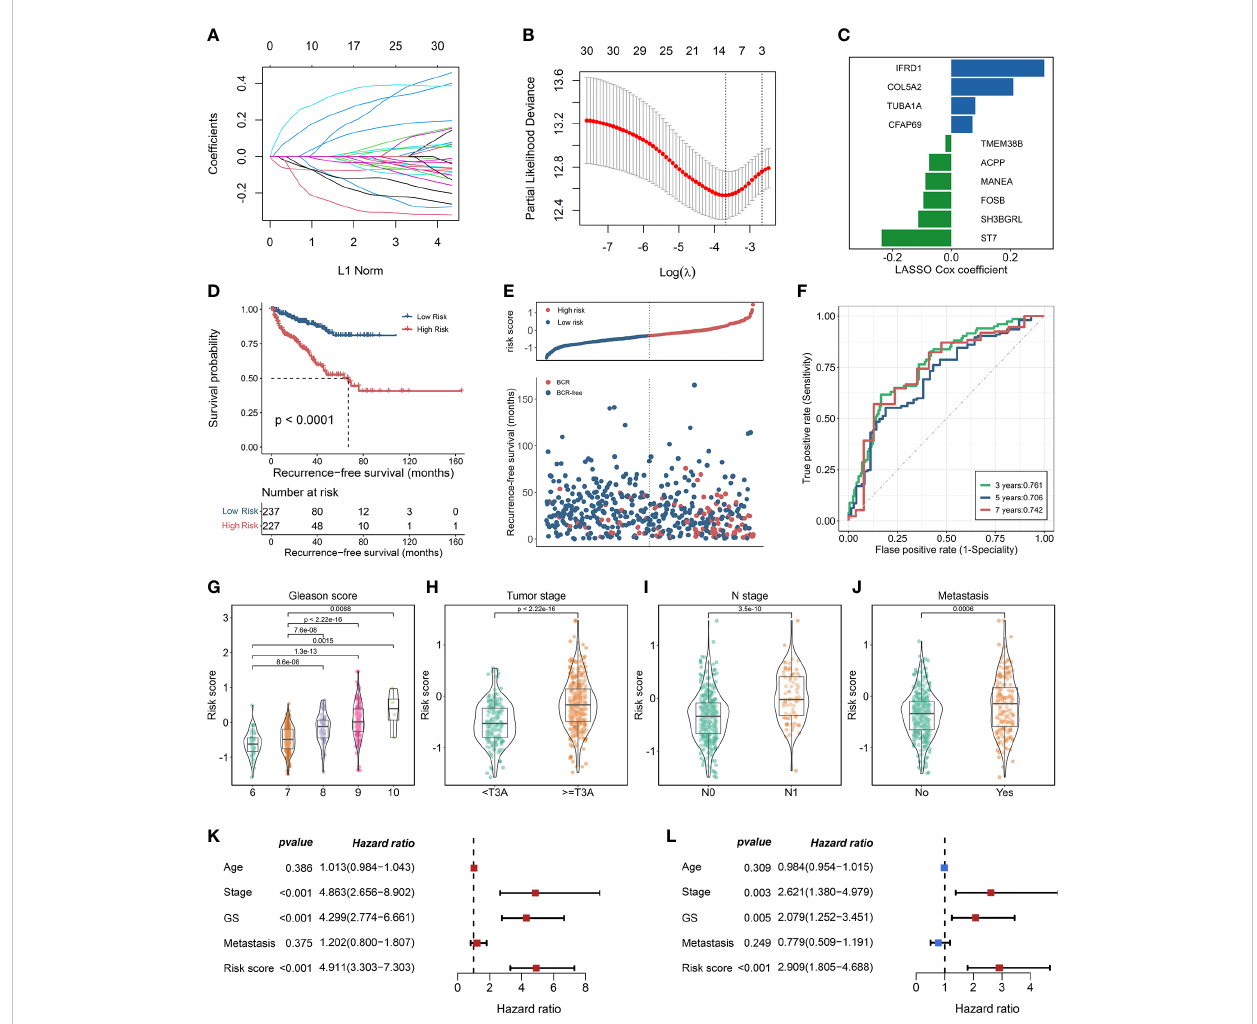
FIGURE 3 Construction of enzalutamide-induced signature and its clinical relevance. (A) Lasso cox regression coef fi cients of 31 candidate genes. (B) Partial likelihood deviance of candidate genes derived from lasso Cox regression analysis with 10-fold cross-validation. Two vertical dotted lines represent minimum mean cross-validation error and one standard error of the minimum, respectively. (C) The coef fi cients of 10 genes selected from lasso Cox regression model. (D) Kaplan – Meier curve in terms of RFS for high-risk and low-risk patients divided by enzalutamide-induced signature. (E) The risk score and recurrence-free survival status based on TCGA-PRAD cohort. (F) The receiver operating characteristics curve for the prediction of 3-, 5-, and 7-year RFS based on the risk score derived from enzalutamide-induced signature. The abundance of risk score calculated by enzalutamide-induced signature in different clinicopathological characteristics, including Gleason score (G) , tumor stage (H) , N stage (I) , and metastasis status (J) . Univariate Cox regression analysis (K) and multivariate Cox regression analysis (L) for enzalutamide-induced signature and clinical variables, including age, stage, Gleason score, and metastasis